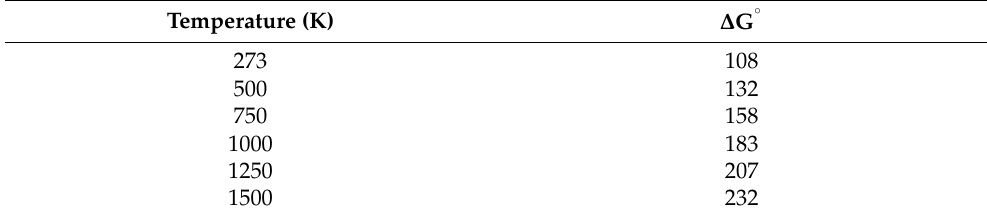
Table 2. Free energy Gibbs of CH 4 + H 2 O → CH 3 OH + H 2 at various temperature. Temperature